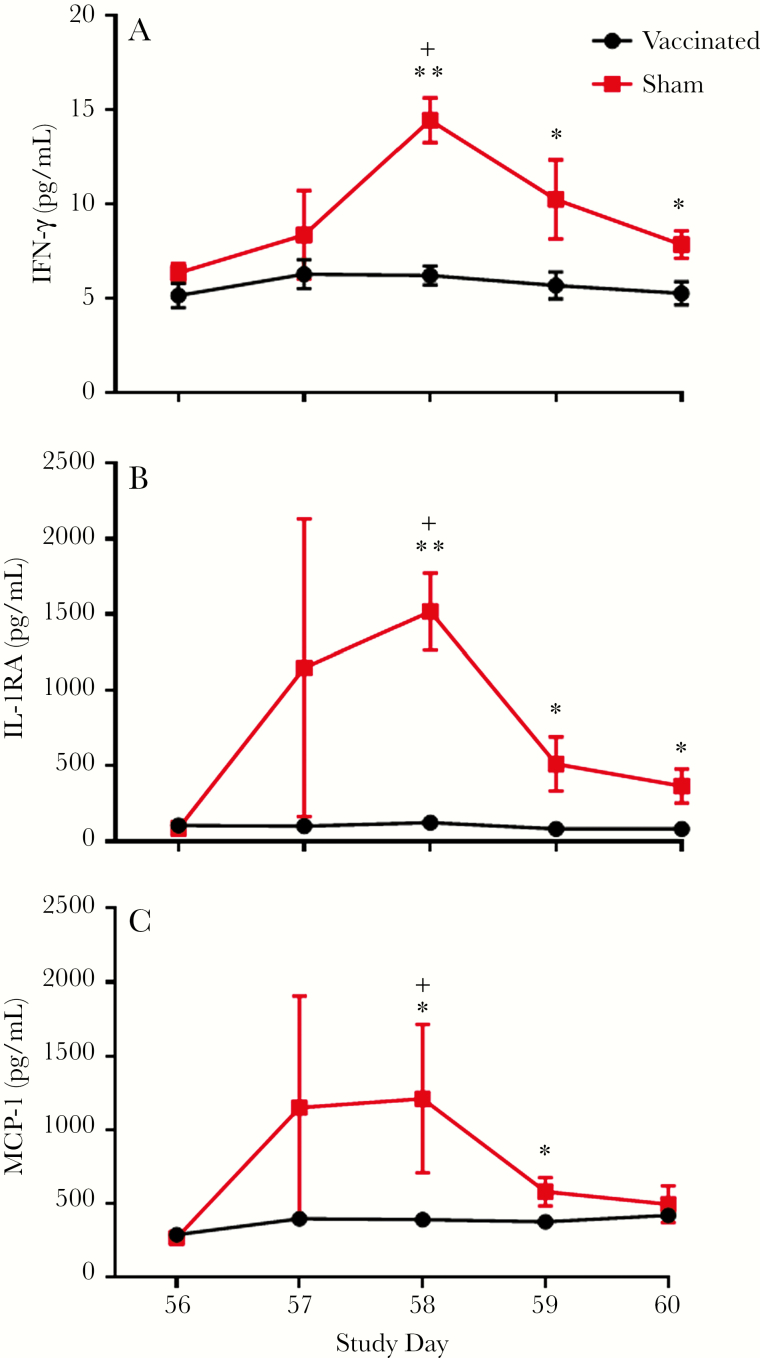
Mean levels of circulating cytokines in nonhuman primate serum assayed using the Monkey Cytokine Magnetic 29-Plex Panel (Invitrogen). Mean levels of interferon (IFN)-γ (A), interleukin (IL)-1RA (B), and monocyte chemoattractant protein-1 (MCP-1) are presented. One-way analysis of variance followed by Tukey’s multiple group comparisons were performed on the different time points for a given group; +, P < .05. Differences between groups were determined using an unpaired t test; *, P < .05 and **, P < .001. Bars indicate standard errors.